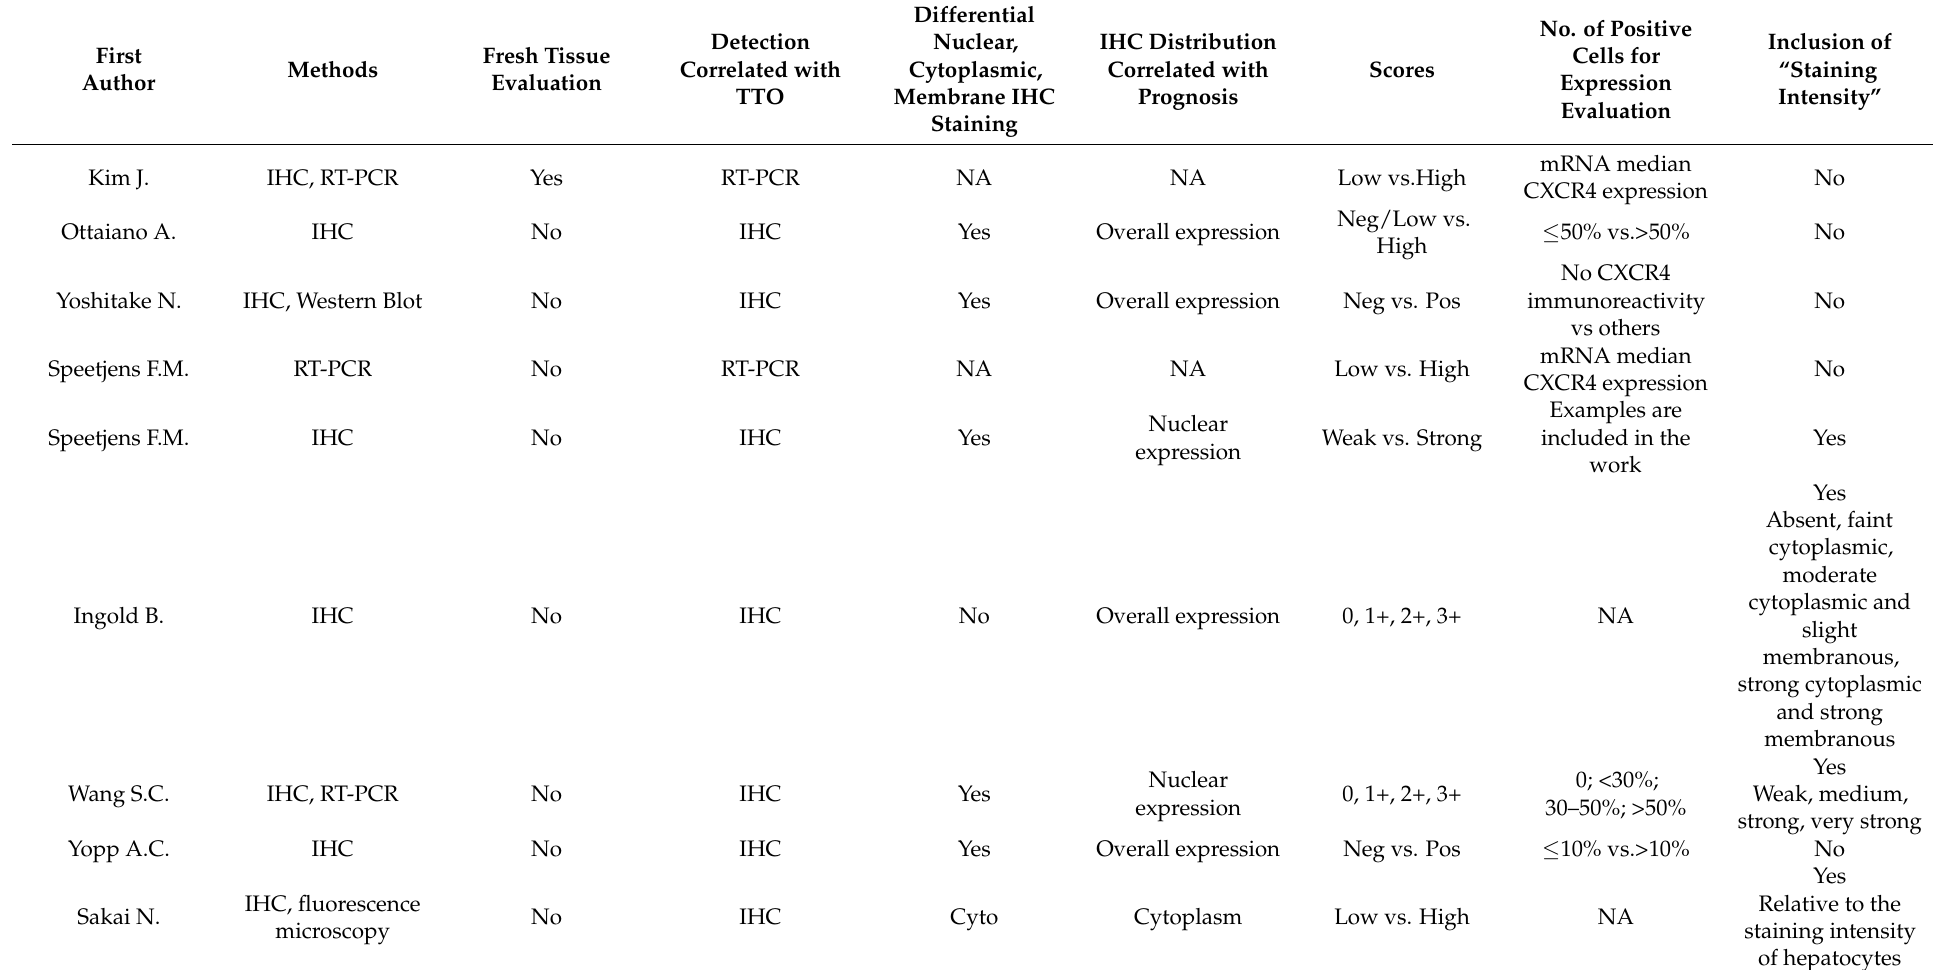
Table 1. Description of CXCR4 assessment methodology among selected